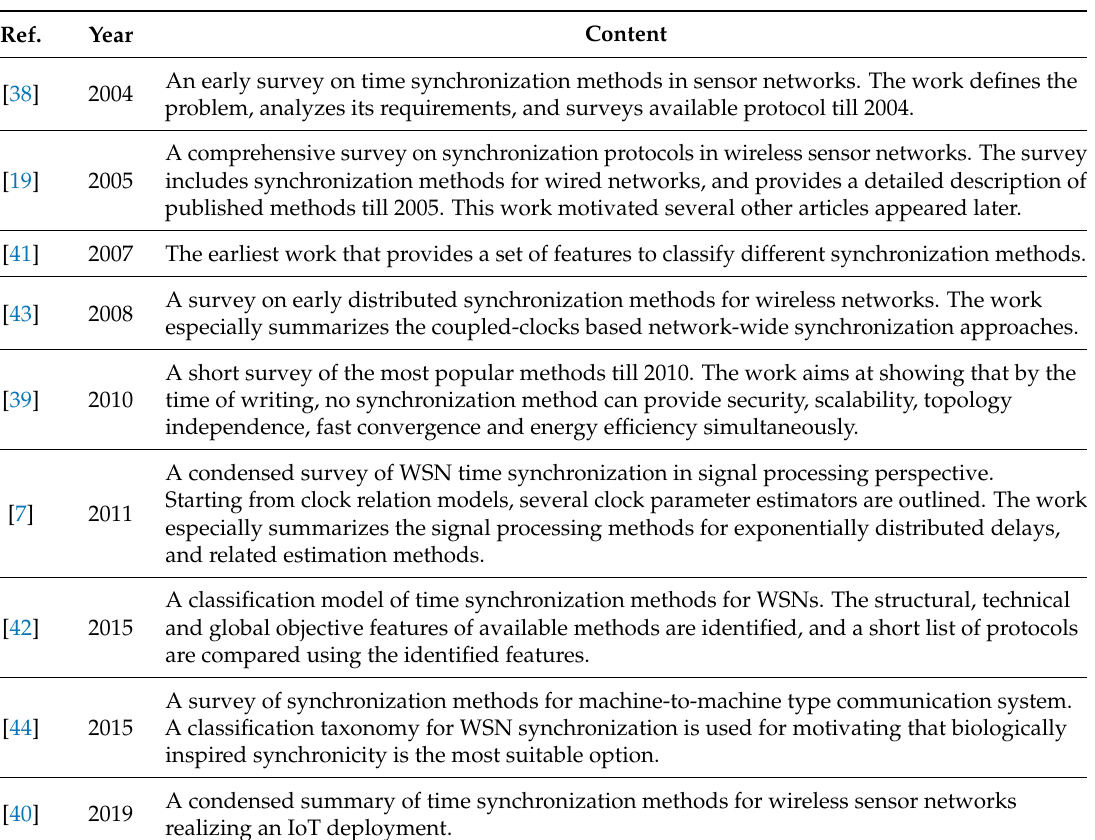
Table 1. Surveys on time synchronization in